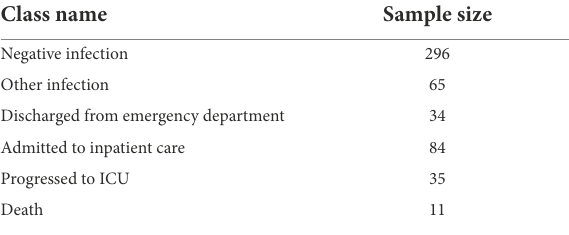
TABLE 1 Sample size of each class for the methylation